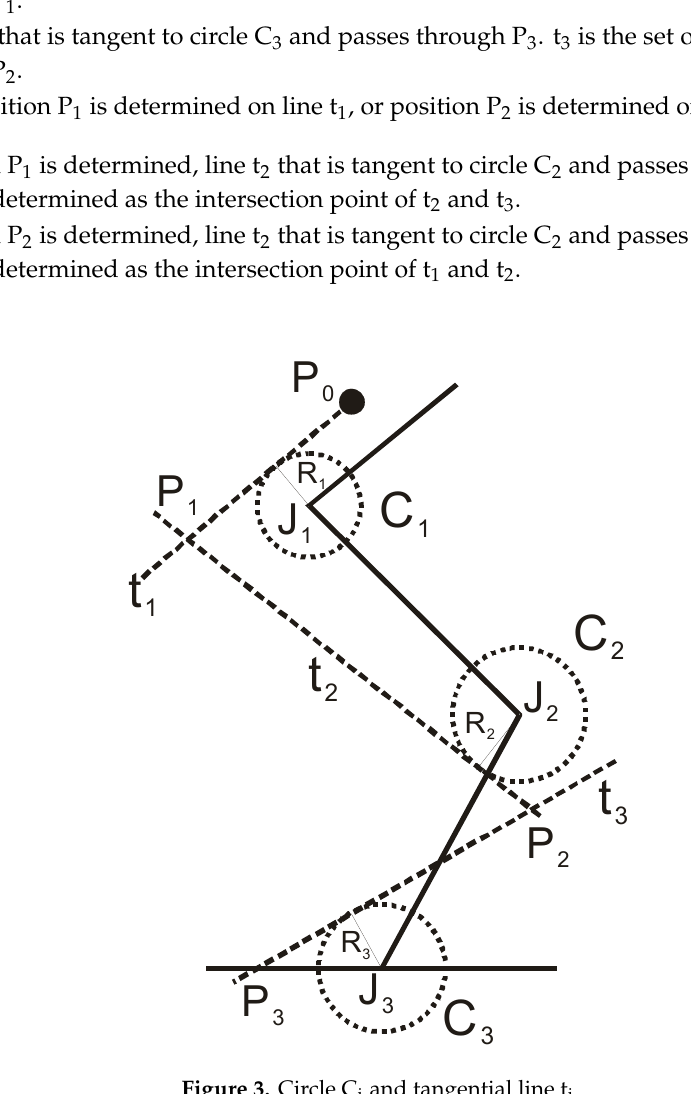
Figure 3. Circle C i and tangential line t i.